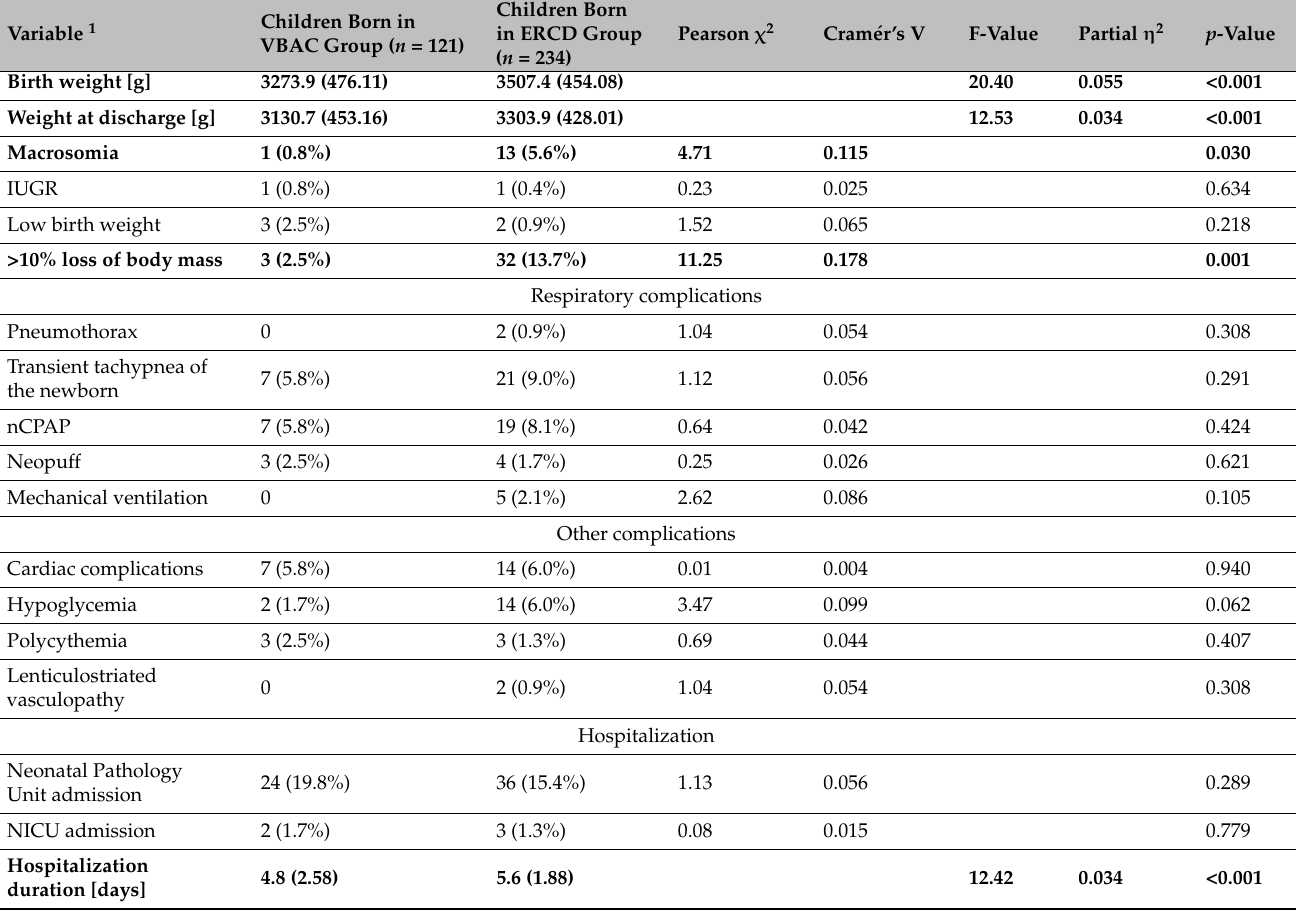
Table 2. Neonatal characteristics and